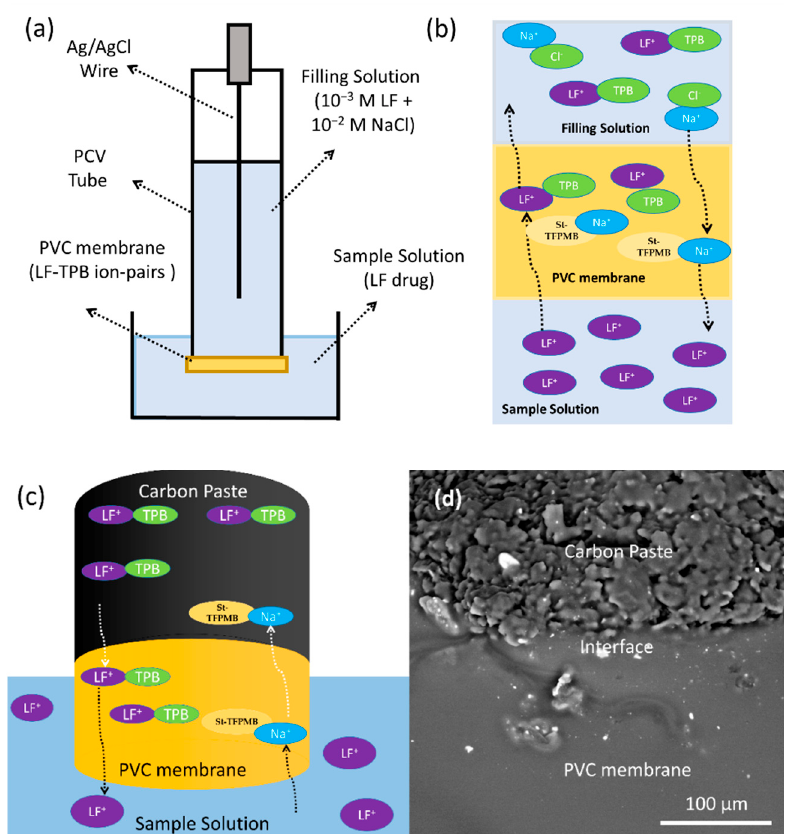
Figure 3. Design of the prepared electrodes and their response characteristics as a potentiometric sensor for LF drug de- termination at room temperature of 22 ± 2 °C: ( a ) construction of the PVCEs; ( b ) mechanism of ion-pairs exchange between the samples solution, PVC membrane, and filling solution of the PVCEs; ( c ) mechanism of ion-pairs exchange between the samples solution, PVC membrane, and carbon paste of the C-CPEs; ( d ) SEM image of C-CPEs showing the PVC membrane coated on the carbon paste and the interface area between the PVC membrane and the carbon paste.